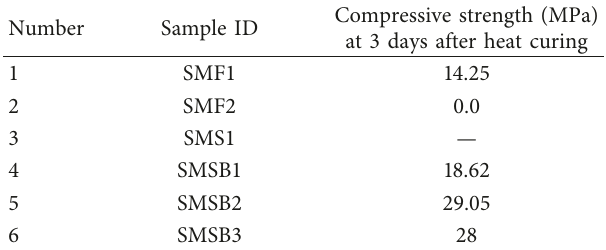
Table 3: Compressive strength at 3 days after heat curing.